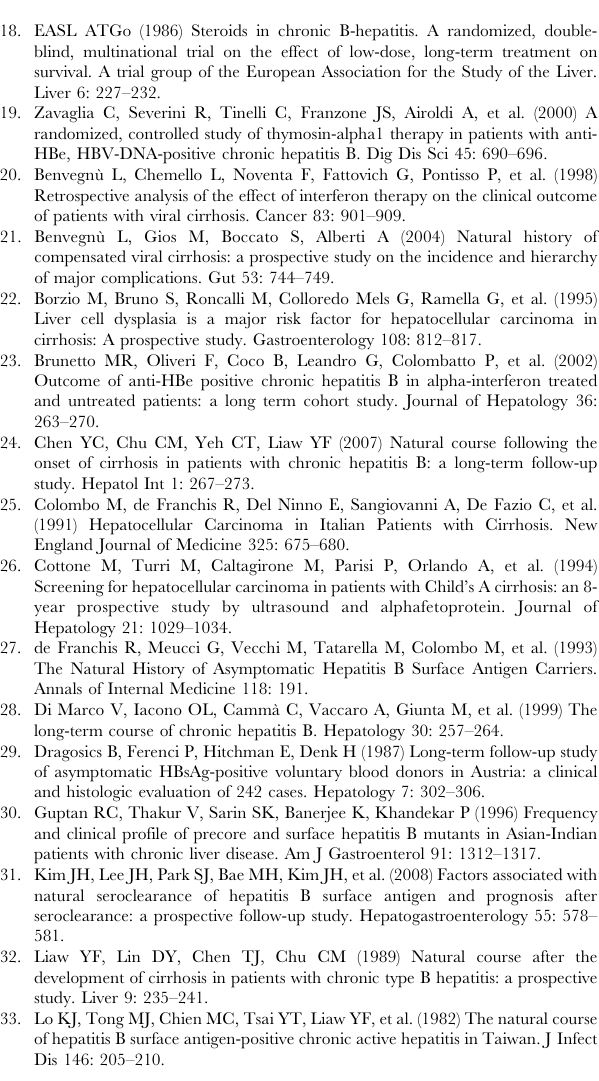
Figure S1 Analysis of the influence of a single study on the overall estimate in the meta-analysis, HCC inci- dence. Figure S2 Analysis of the influence of a single study on the overall estimate in the meta-analysis, mortality. Table S1 Supplementary table, trial characteristics.